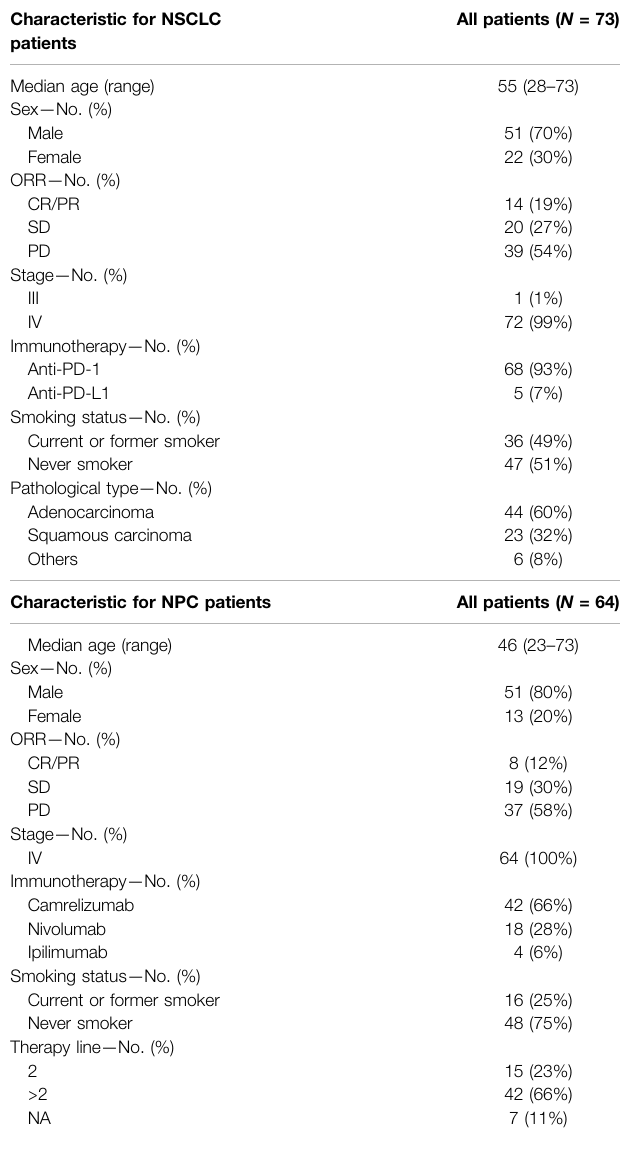
TABLE 2 | Baseline clinical characteristics for NSCLC patients and NPC patients. Characteristic for NSCLC